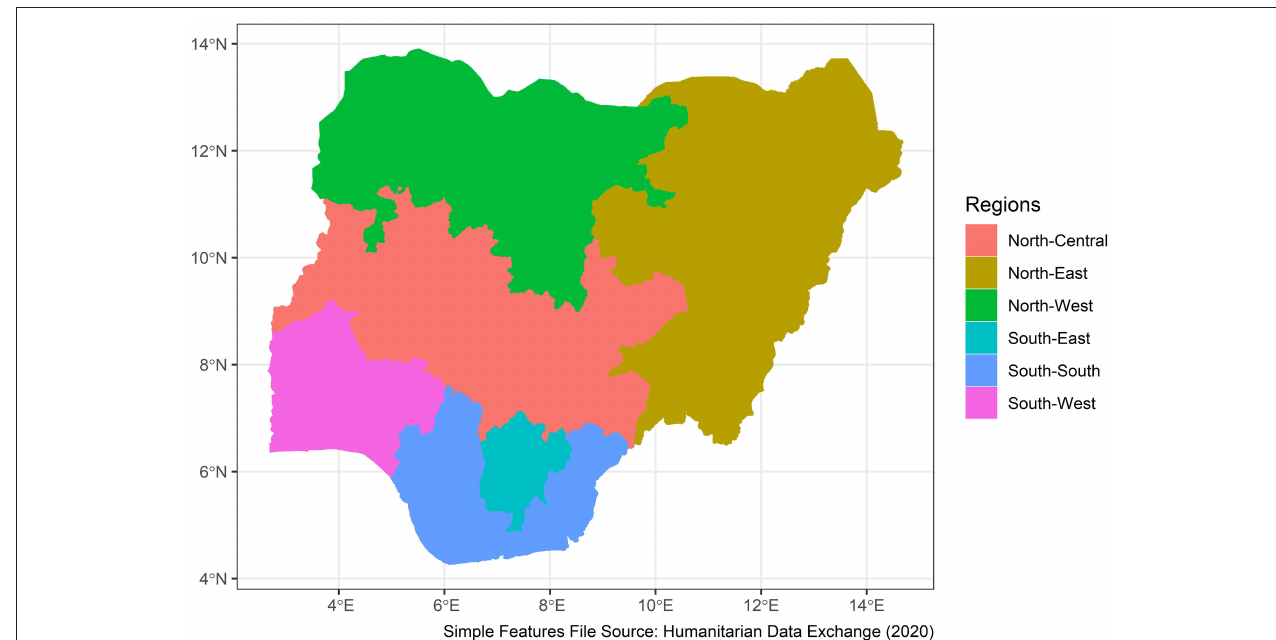
FIGURE 1 | Geo-political zones in